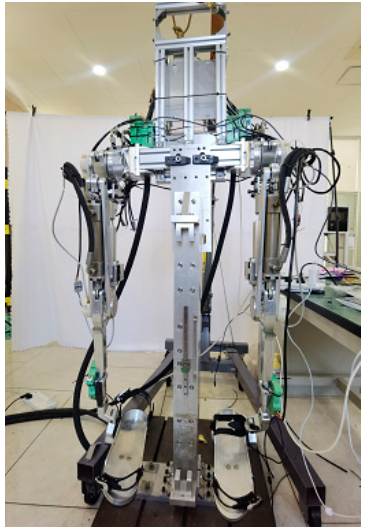
Figure 26. Stability test.